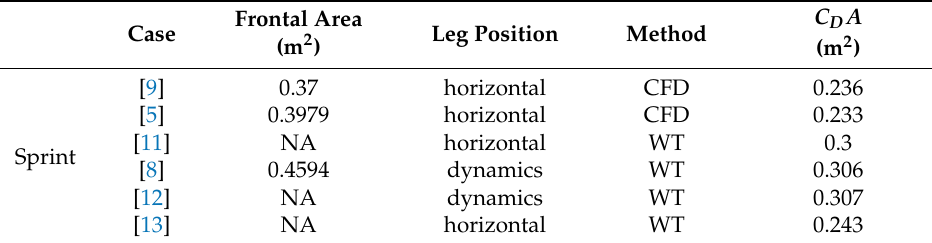
Table 1. Drag measurements/predictions from previous